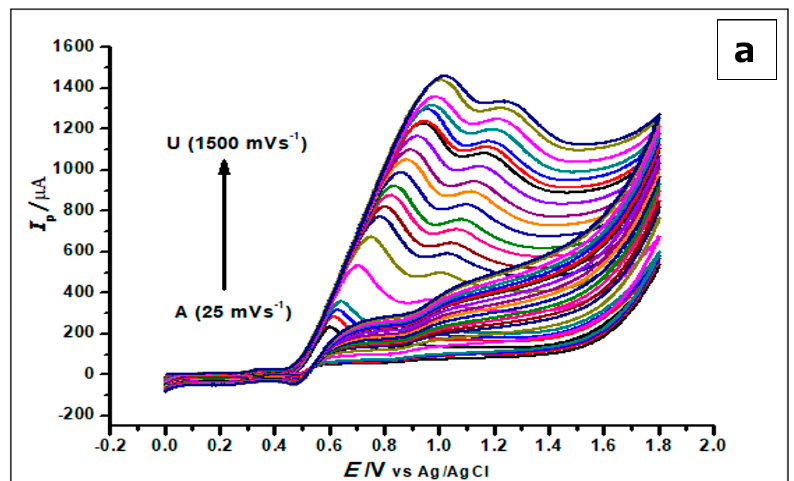
Figure 9. The plot of the peak potential ( E p ) against the different pH values of the buffer solution, showing a linear